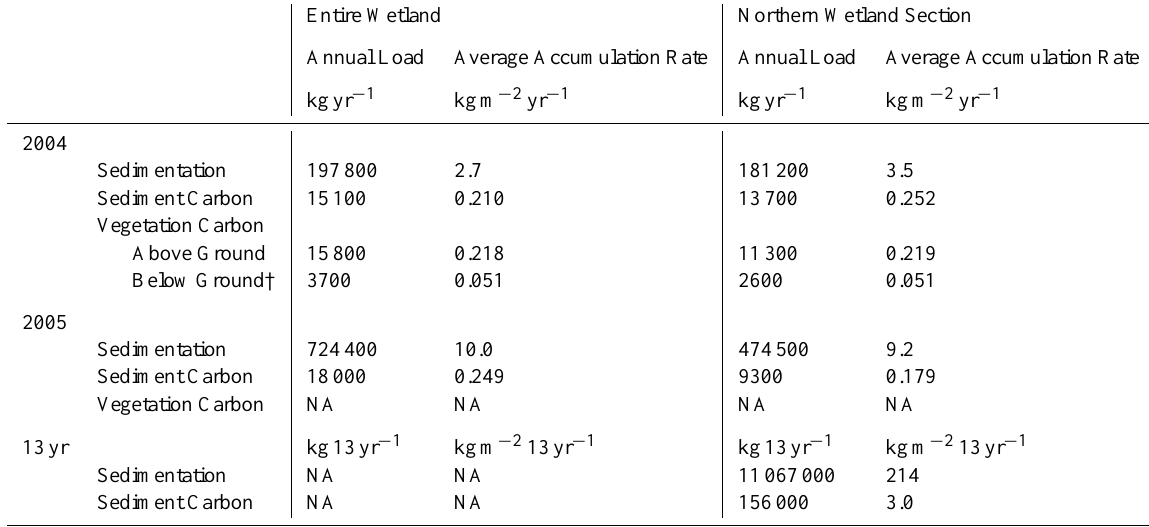
Table 2. Annual sediment and C loads and accumulation rates for seasonally submerged soils in 2004 and 2005 for the whole wetland. Entire Wetland Northern Wetland Section Annual Load